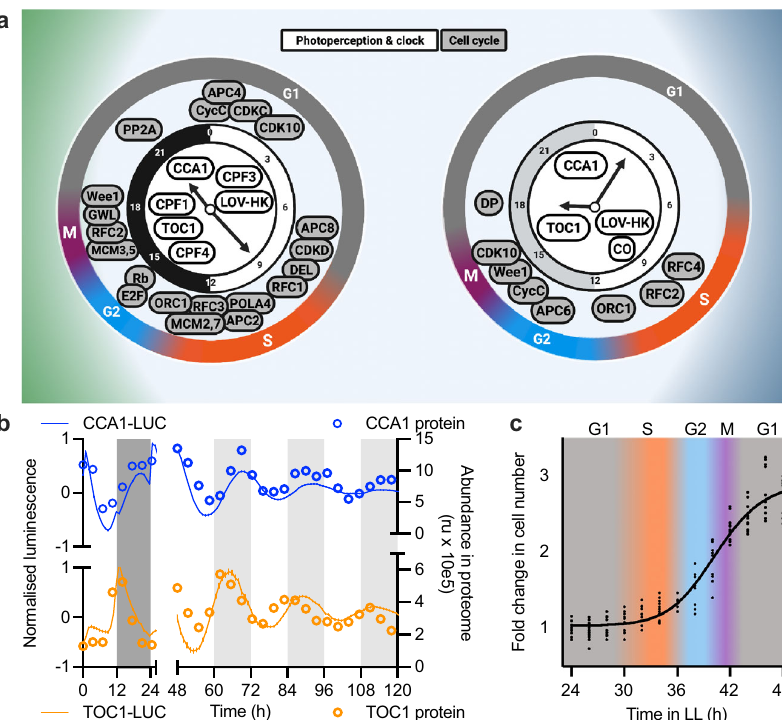
Fig. 2 Proteome data accurately represent cellular rhythmicity. a Diagrams depicting the key rhythmically abundant proteins of the circadian and photoperception systems (white) or the cell cycle (grey), expressed on a 24 h clock face based on their peak phase under LD or LL. b The relative abundance of TOC1 and CCA1 in LD (0 – 24 h) and LL (48 – 120 h) as determined by proteomics (data points, right Y -axis) or luciferase results (lines, left Y -axis; mean of n = 30 (TOC1-LUC) or n = 48 (CCA1-LUC)). c The cell cycle phases inferred from proteomics, overlaid with observed cell division events under LL. Source data for proteomics results can be found in Supplementary Data 1.